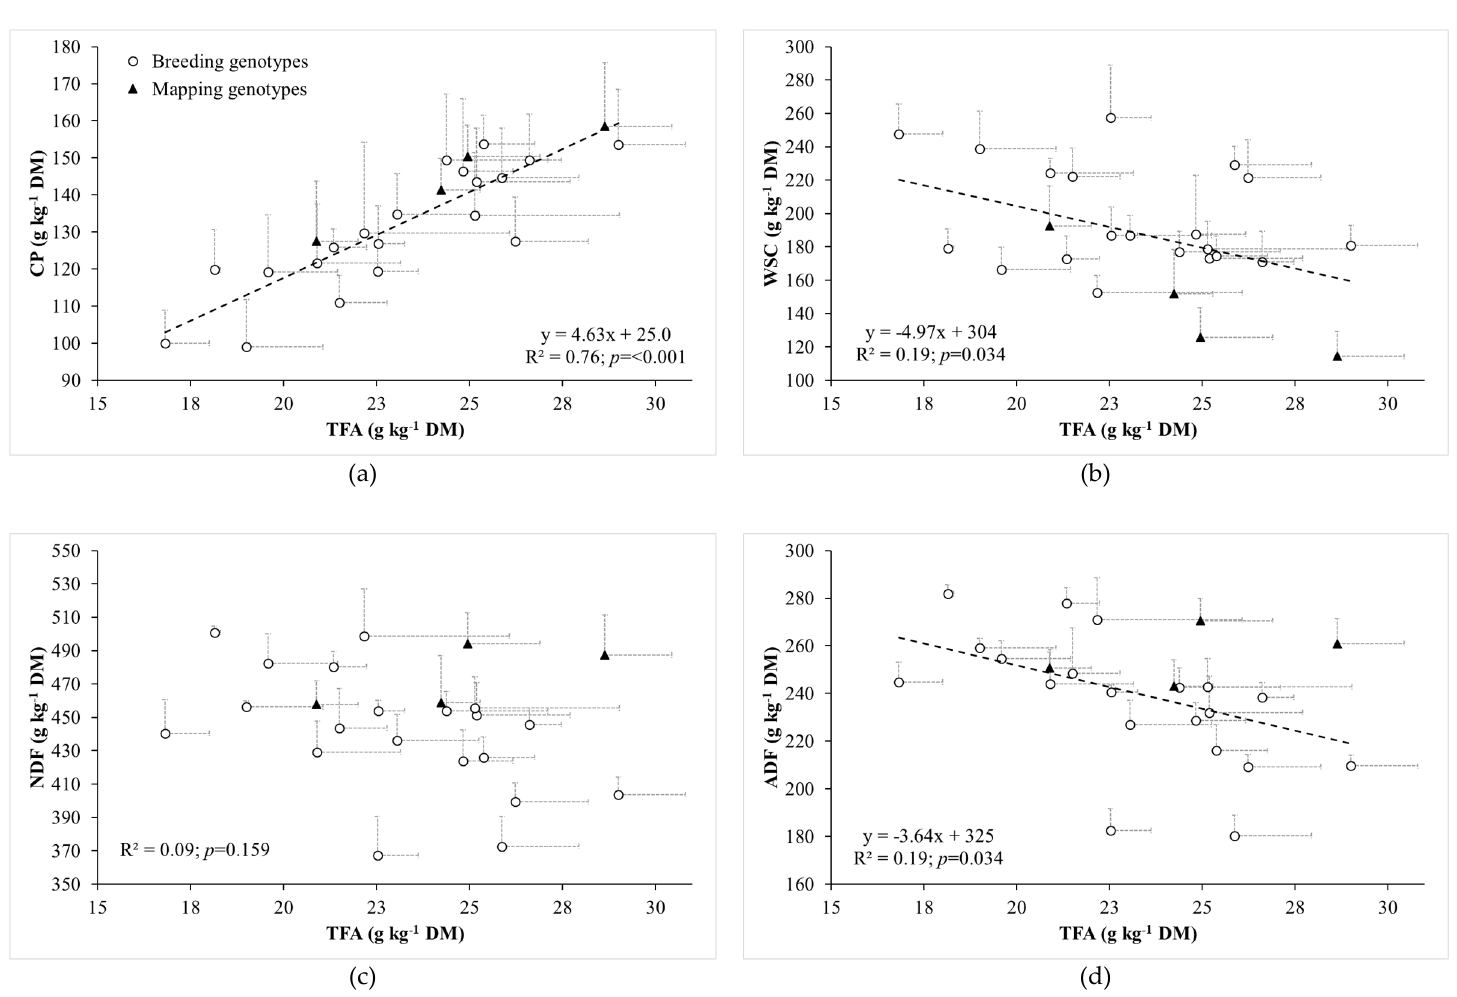
Figure 1. Relationships between ( a ) crude protein (CP), ( b ) water-soluble carbohydrates (WSC), ( c ) neutral detergent fibre (NDF) and ( d ) acid detergent fibre (ADF) with total fatty acid (TFA) concentrations ( n = 24). Grey dashed lines indicate standard error of the mean for each genotype.